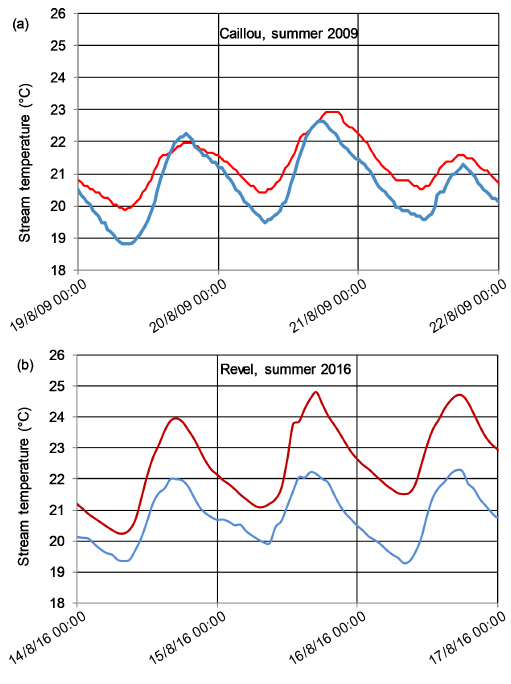
Figure 7. Time series of water temperatures upstream (blue line) and downstream (red line) of the (a) Caillou (Vieux Jonc stream) and (b) Revel (Solnan stream) dams for 3d during